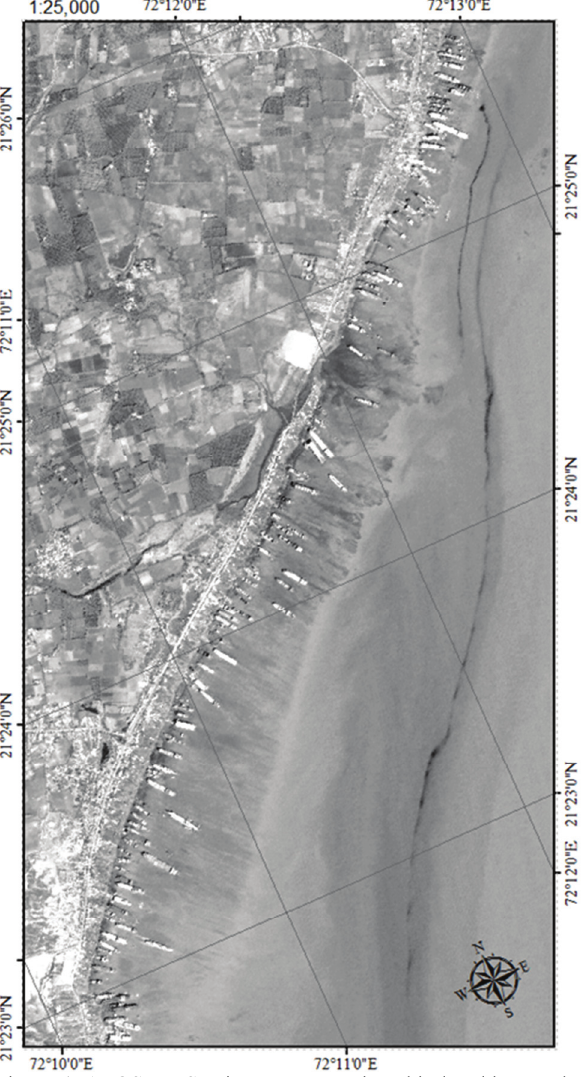
Figure 4. ALOS PRISM imagery capturing ship breaking yards